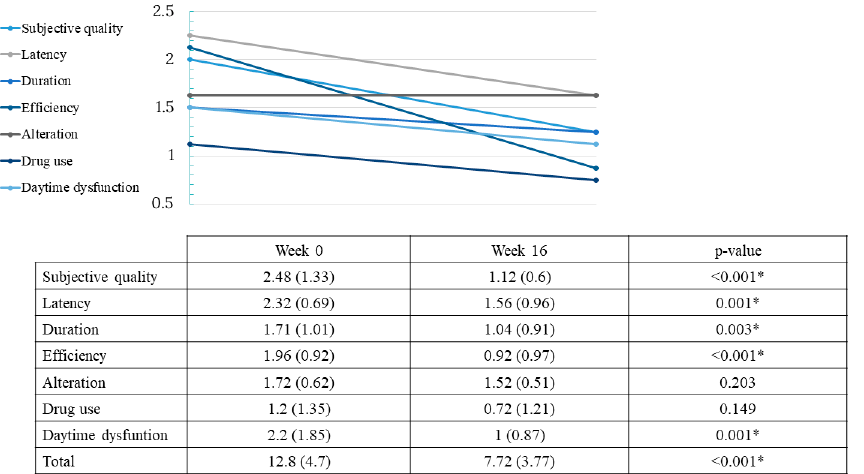
Figure 4. Effect of dupilumab on sleep quality. Values of total PSQI and subcategories on weeks 0 and 16. Two-tailed * p < 0.05 was considered statistically significant in all tests.